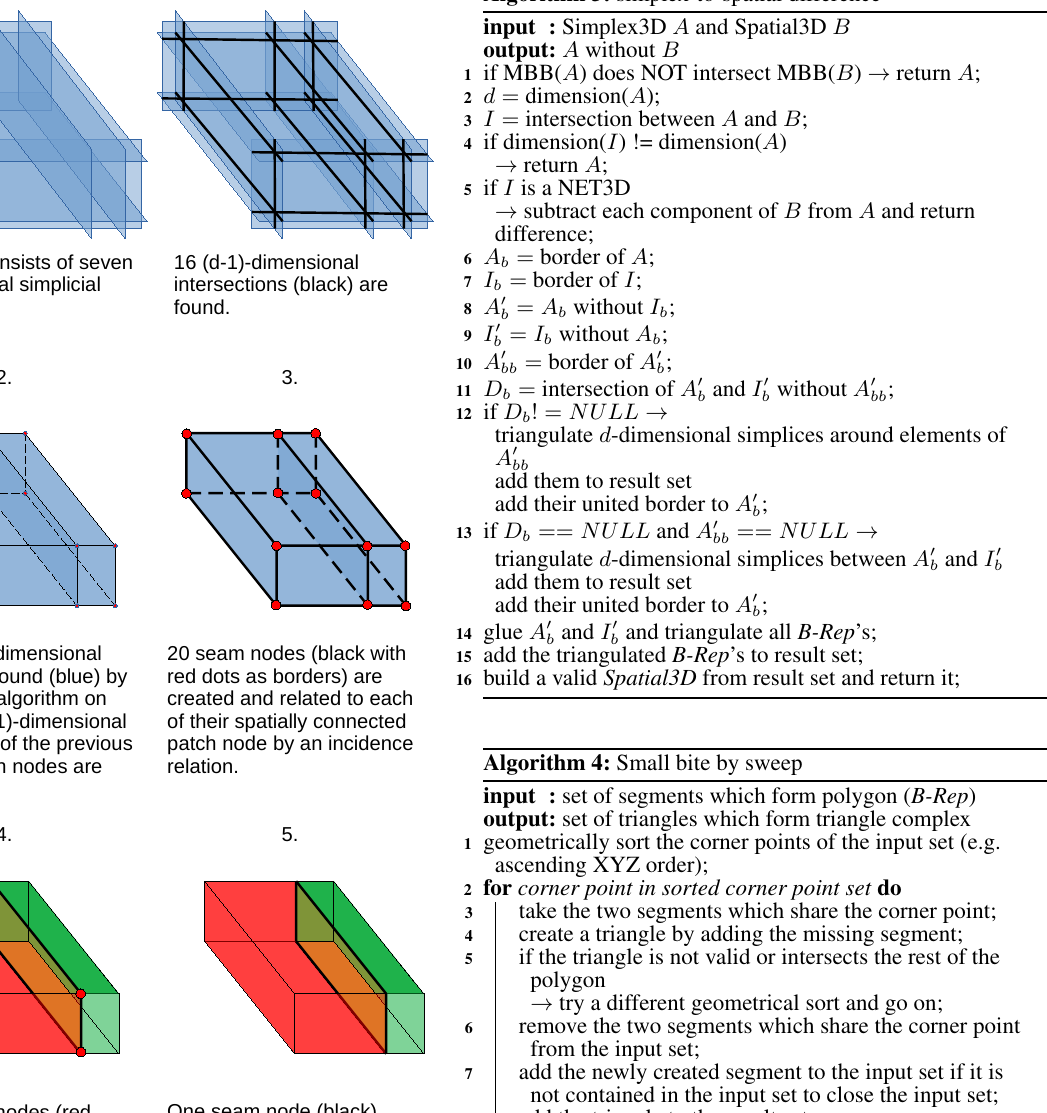
Algorithm 3: simplex-to-spatial difference